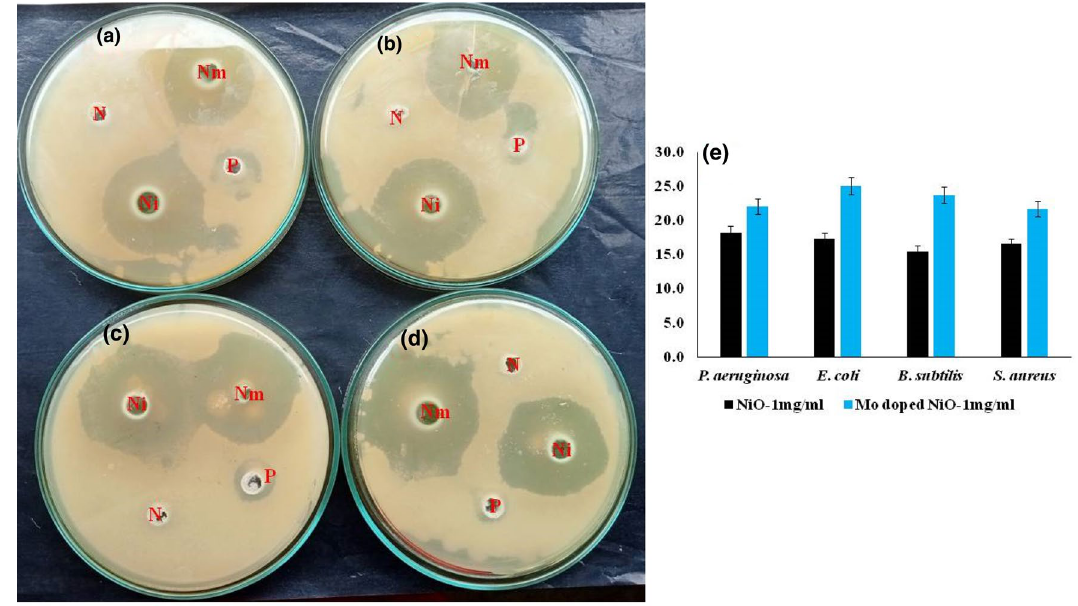
Figure 8. Antibacterial efficacy of Ni and Mo doped NiO against ( a ) P. aeruginosa , ( b ) E. coli, ( c ) S. aureus, and ( d ) B. subtilis . ( e ) Comparative bar